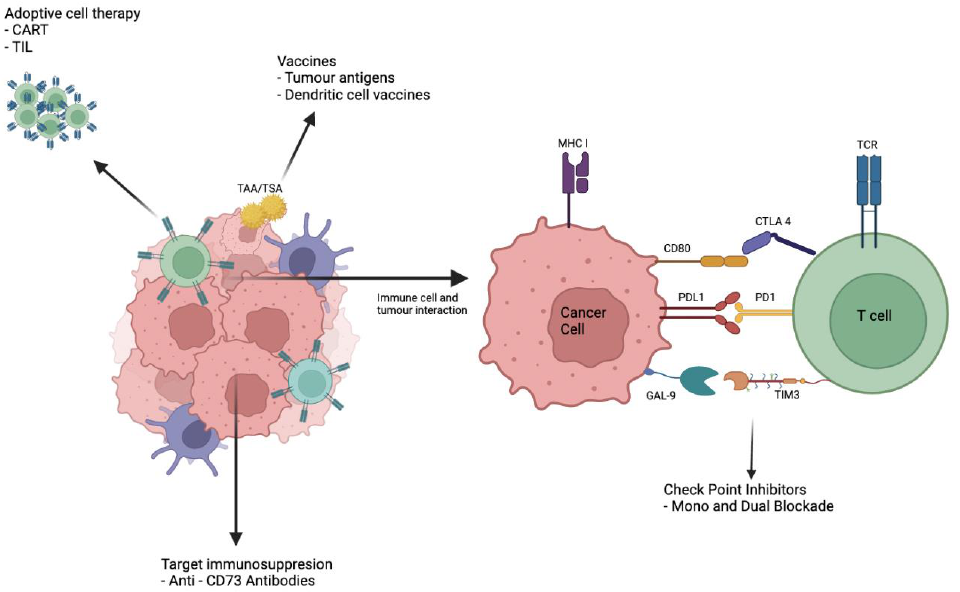
Figure 1. Illustration demonstrating potential immunotherapeutic options to treat OC described in this review. CART: Chimeric antigen receptor T cell therapy TIL: Tissue-infiltrating lymphocyte TAA: Tumour-associated Antigen TSA: Tumour-specific antigen. (image created with biorender.com, accessed on 25 May 2022).